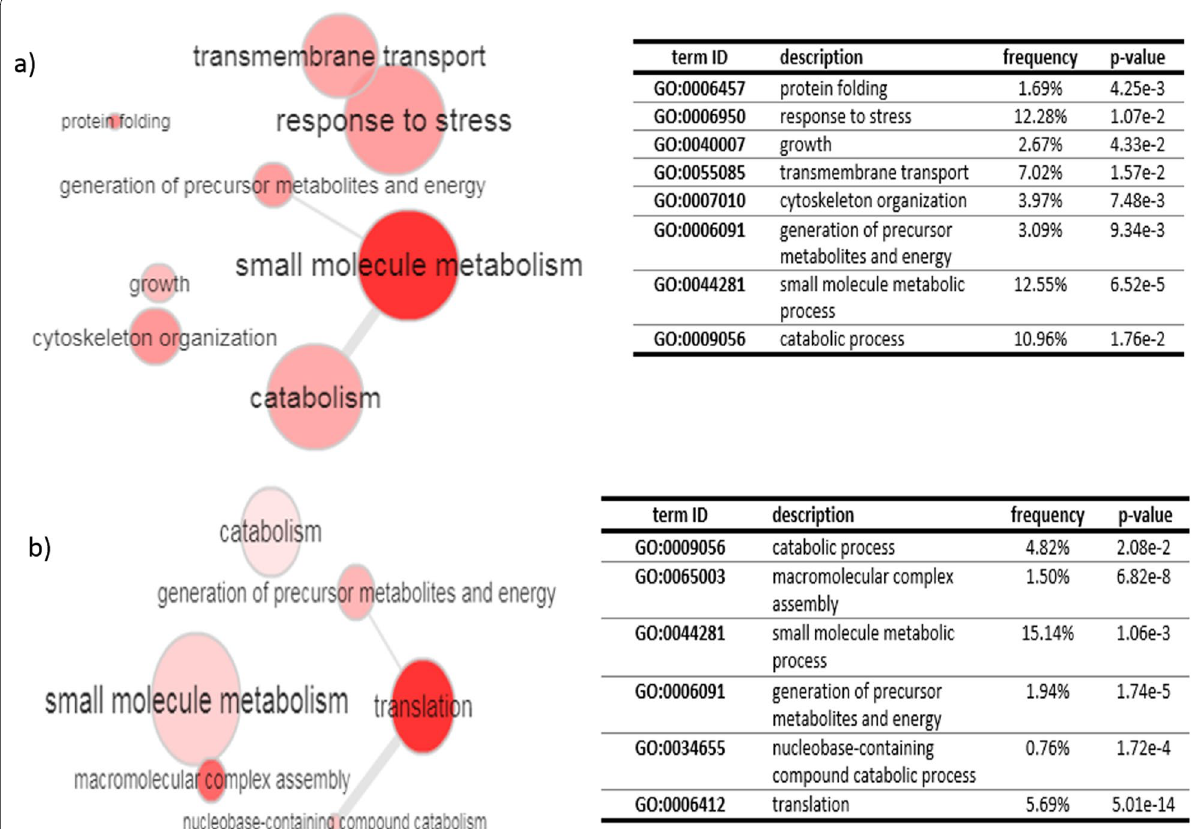
Table 2 The KEGG pathways of up‑regulated proteins during conversion of L. tropica metacyclic into the amastigote‑like Pathway ID pathway description Gene No.